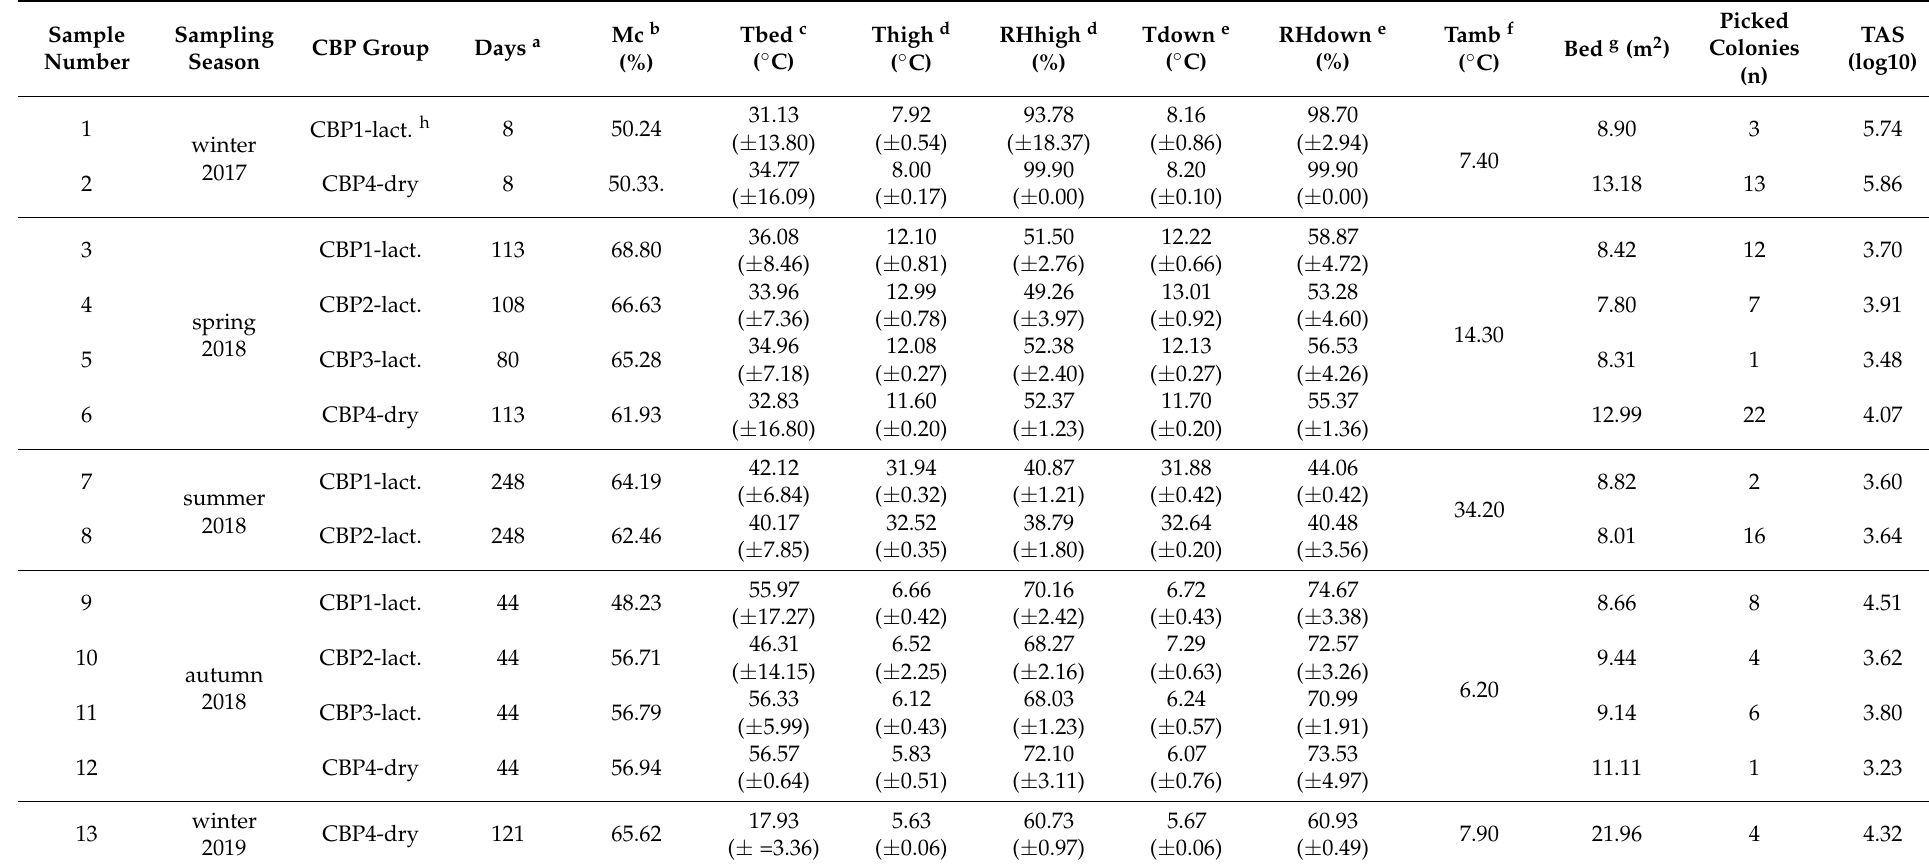
Table 1. Moisture content, means for temperatures and relative humidities (standard deviation in brackets) and thermophilic aerobic sporeformers (TAS) concentrations in 13 different compost-bedded pack barns (CBP)